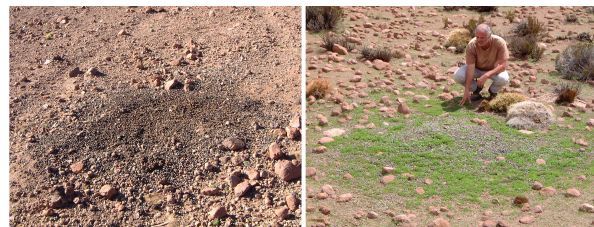
Fig. 6. Concentrated nitrogen input caused by excrements and urine of vicu˜na and guanaco. Note the narrow lawn of a special herb com- munity adapted to the strong eutrophication on the right picture after several downpours at the base of Volc´an Sairecabur at 3900ma.s.l. Left: dry deposits at the base of Volc´an Llullaillaco at 4500ma.s.l. (photos: March 2001).